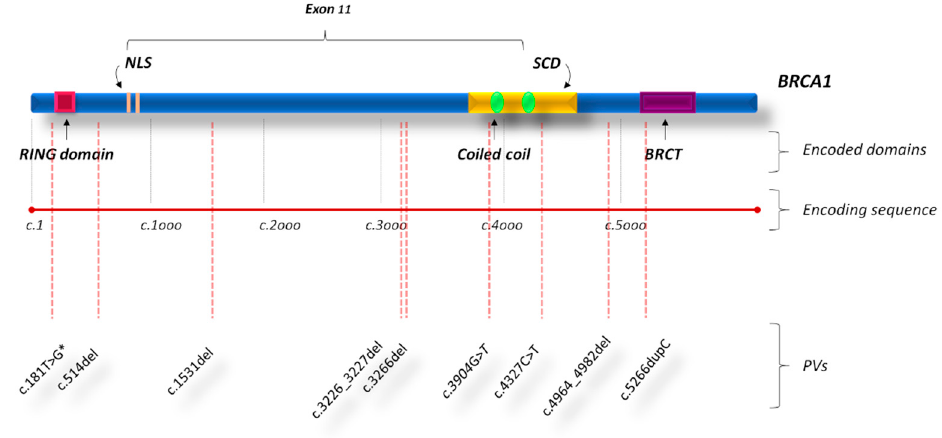
Figure 2. BRCA1 functional domains and gene location of BRCA1 PVs in bilateral breast cancer patients. Abbreviations: BRCT, BRCA1 C-terminus domain; NLS, nuclear localization sequence; PVs, pathogenic variants; SCD, serine cluster domain. * This PV is present together with the BRCA2 PV named c.8331+2T>C in one patient showing double heterozygosity for BRCA1 and BRCA2 PVs.